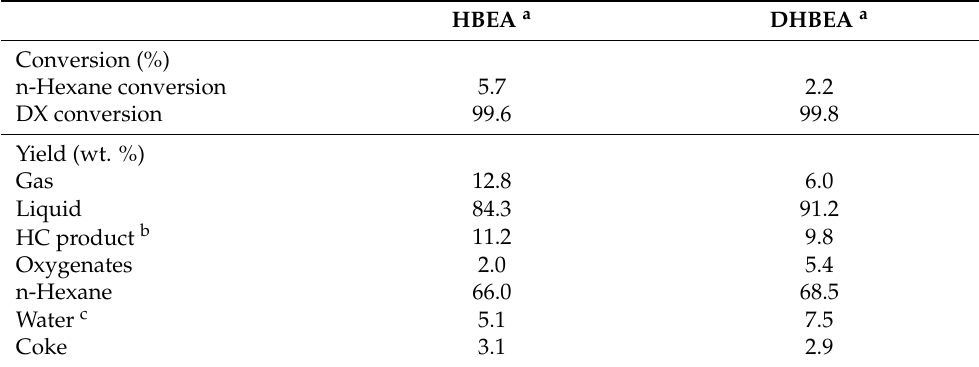
Table 3. Conversions and yields of liquid, gas, coke, unreacted n-hexane, and water were obtained by catalytic cracking with a percentage of 30% DX/n-hexane in HBEA and DHBEA at 720 ◦ C. HBEA a DHBEA a Conversion (%) n-Hexane conversion Yield (wt. %)